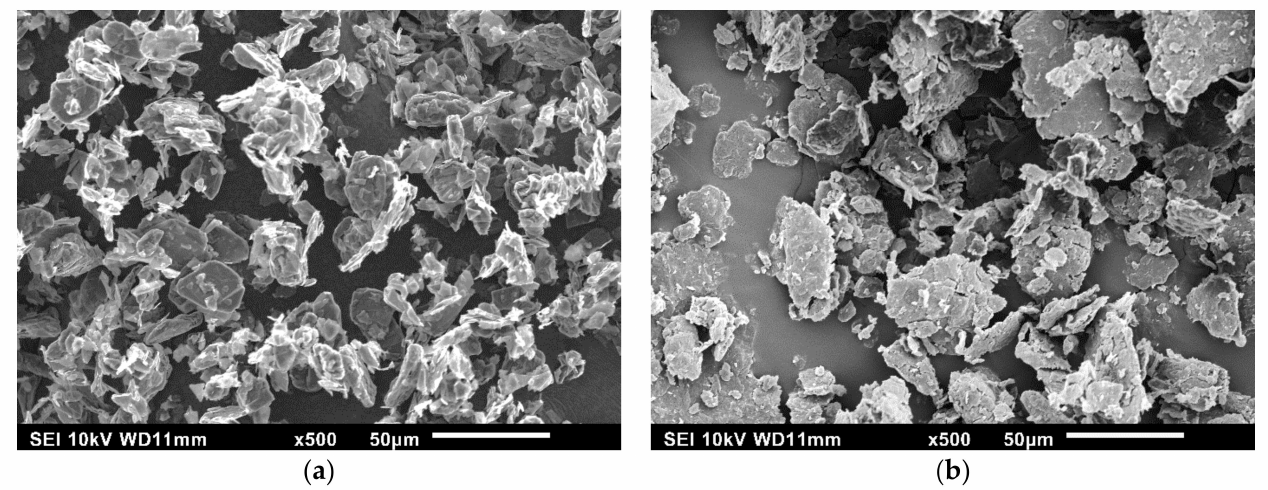
Figure 3. Scanning electron microscopy (SEM) micrograph of ( a ) graphite powder and ( b ) GO